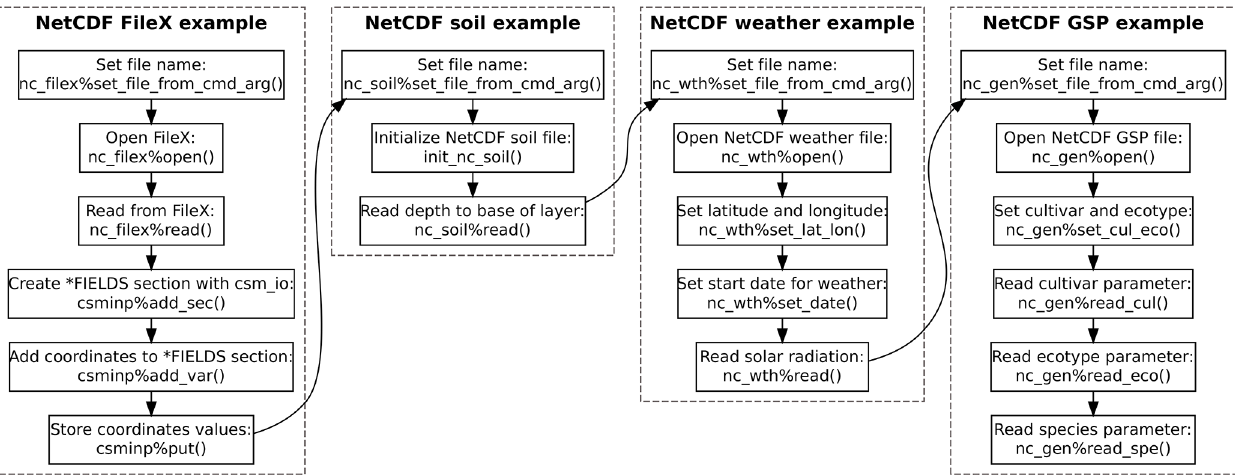
Figure 2. Flowchart illustrating the sequence of operations for reading from NetCDF FileX, soil, weather, and genotype-specific parameter (GSP) files in the example program given in Appendix B and explained in Sect.